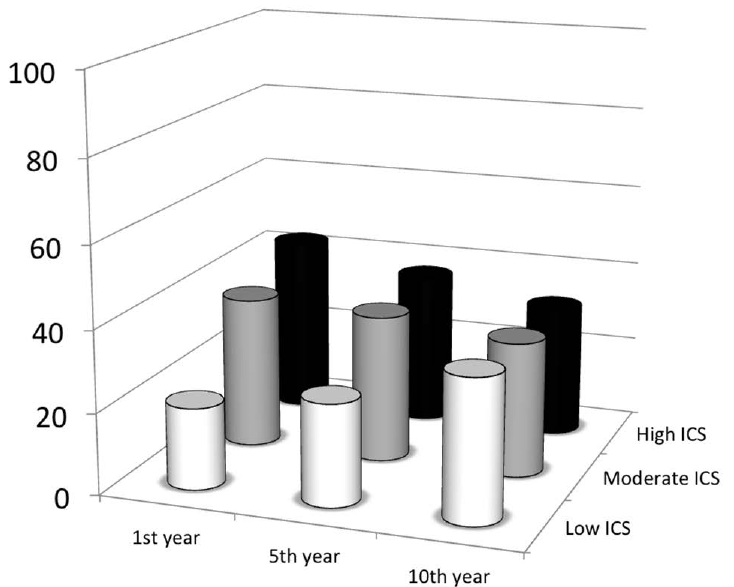
Figure 7. Prevalence of subjects, for each inhaled corticosteroid (ICS) score during the follow-up period. A Scheme of 10th and 5th years ( p < 0.0001, χ 2 ), between 10th and 1st years ( p = 0.003, χ 2 ), and between 5th and 1st years ( p < 0.02, χ 2